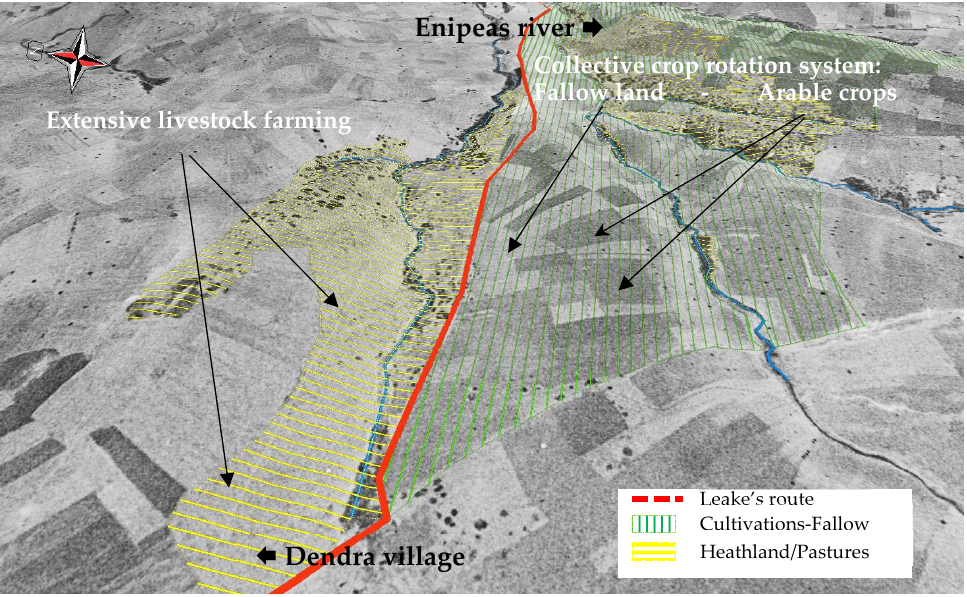
Figure 8. Depiction of the mixed agro-livestock production system.